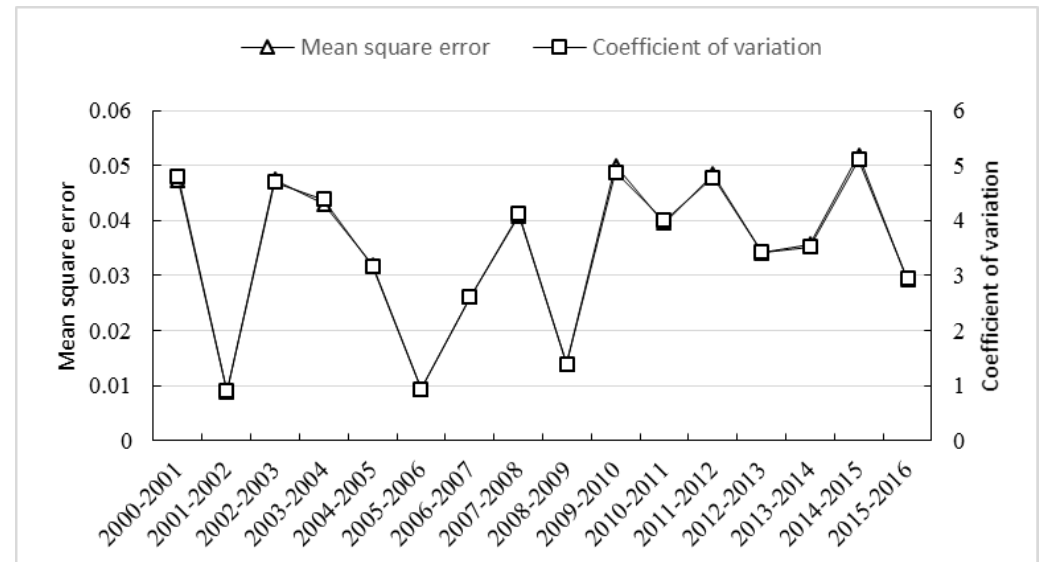
Figure 7. Changes in average variance and coefficient of variation of PEC.